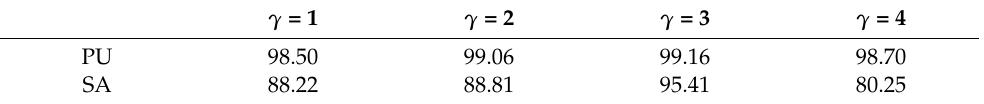
Table 2. The effect of the hyperparameter γ on the overall classification accuracy